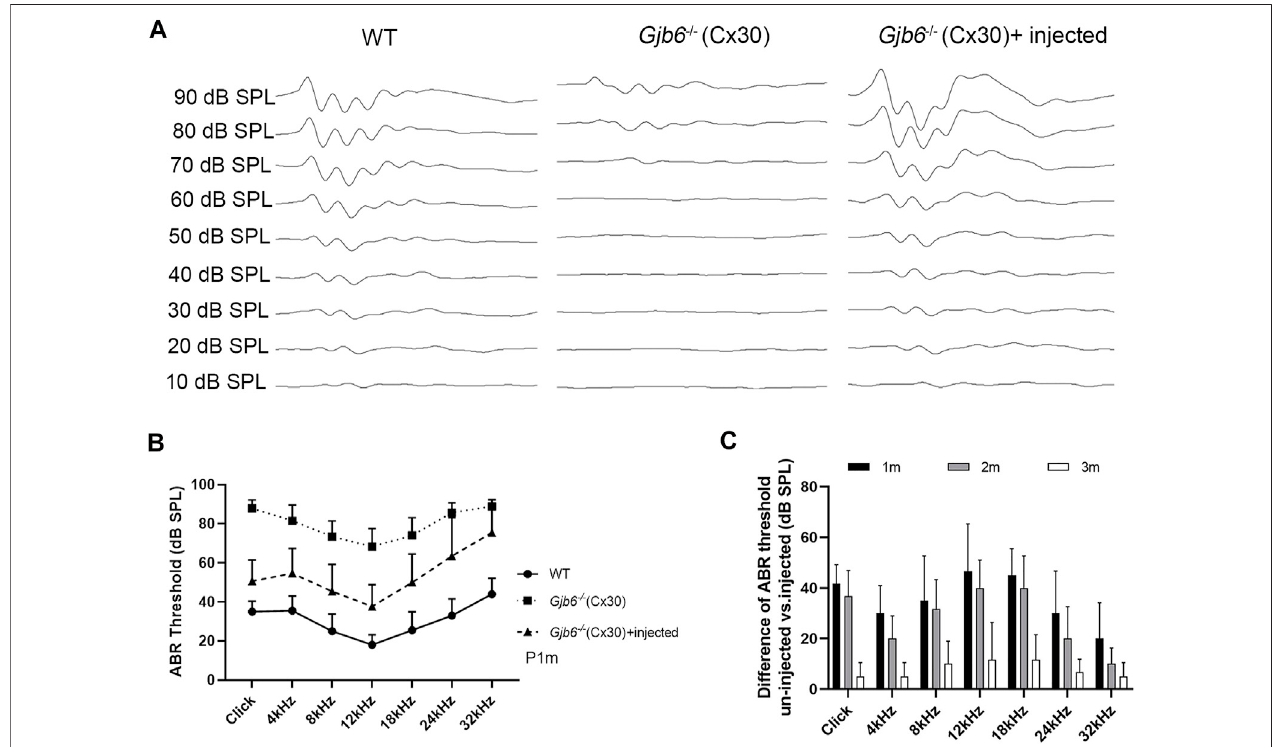
FIGURE 2 | Injection of AAV1-CB7- Gjb2 signi fi cantly preserved ABR thresholds in Gjb6 − / − mice transiently. (A) Waveforms of ABRs recorded at 1 month post- injection from (as labeled) WT, un-injected Gjb6 − / − mouse (data traces in the middle column) and Gjb6 − / − mouse injected with AAV1-CB7- Gjb2 (data traces in the right column). ABRs were recorded using 18 kHz tone bursts at sound pressure levels as indicated at the left of data traces in 10 dB steps ranging a low of 10 to the highest 90 dB SPL. (B) Summary of averaged ABR thresholds tested at 1 month post-injection by click sound, and by tone bursts (presented from 4 to 32 kHz) for three groups of mice: WT ( fi lled circles, n = 14), un-injected Gjb6 − / − ( fi lled square, n = 35) and Gjb6 − / − mice injected with AAV1-CB7- Gjb2 ( fi lled triangles, n = 36). Error bars representthestandarddeviationofthemean. (C) TimecourseofchangesinthedifferenceinABRthresholdsbetweentheinjectedandun-injectedearsastestedbyclick and by tone bursts, as measured at 1, 2 and 3 months post-injection (labels given at the top of panel). Error bars in (B,C) represent the standard deviation of the